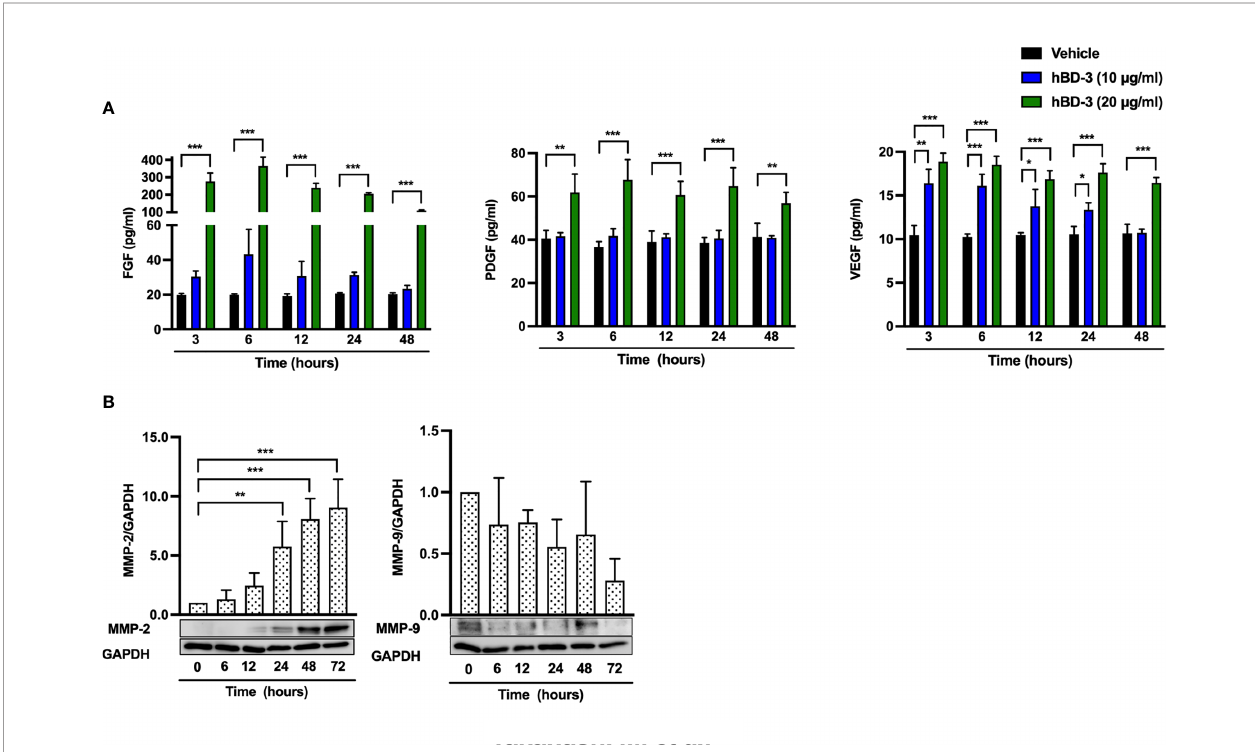
FIGURE 5 | hBD-3 increases the production of angiogenic growth factors and the expression of MMP-2 in fi broblasts. (A) Fibroblasts were stimulated with 10-20 µg/ml hBD-3 or 0.01% acetic acid (vehicle) for 48 hours, and the amounts of VEGF (left panel), PDGF (middle panel) and FGF (right panel) released in the culture supernatants were determined by ELISAs. (B) Fibroblasts were stimulated with 20 m g/ml hBD-3 for 6 to 72 hours and subjected to Western blotting using antibodies against MMP-2 and MMP-9. Bands were quanti fi ed using densitometry. The P value was calculated using one-way ANOVA with Tukey ’ s multiple comparisons test. * P < 0.05, ** P < 0.01, and *** P < 0.001 for comparisons between vehicle and hBD-3. n =